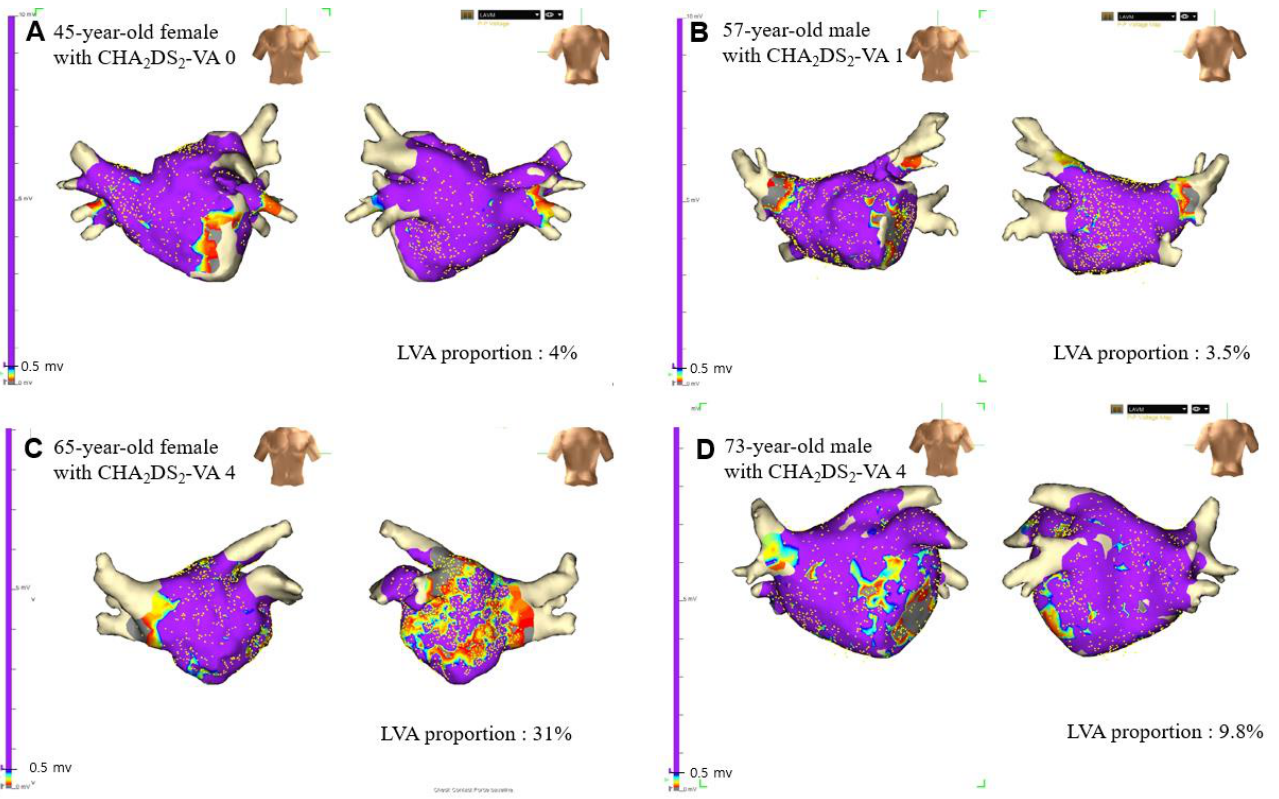
Figure 1. The left atrial bipolar voltage map of representative female ( A , C ) and male ( B , D ) patients. The color gradient indicates serial changes in the electrogram amplitude from purple at >0.5 mV to gray at <0.1 m. The proportion of low voltage area was 4% in a 45-year-old female patient with CHA 2 DS 2 -VA score of 0 ( A ) and 3.5% in a 57-year-old male patient with CHA 2 DS 2 -VA score of 1 ( B ). The burden of low voltage area was extensive (31%) in a 65-year-old female patient with CHA 2 DS 2 -VA score of 4 ( C ), while the low voltage area proportion was 9.8% in a 73-year-old male patient whose CHA 2 DS 2 -VA score was 4 ( D ).